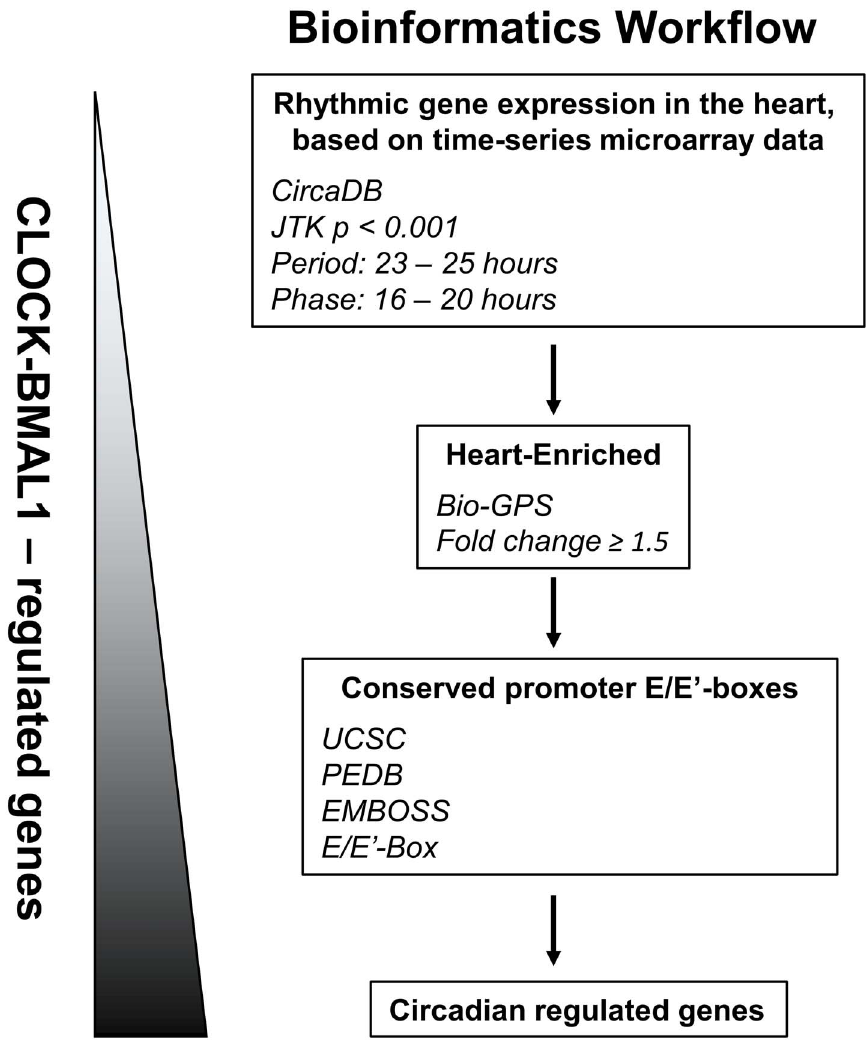
Figure 1. Novel bioinformatics workflow to identify circadian regulated cardiac genes. Distinct patterns of circadian gene expression in the heart were visualized using the Circadian Expression Profiles Data Base (CircaDB) and embedded JTK_Cycle algorithm [19–22] using the JTK_Cycle parameters p , 0.001, period 23 h to 25 h, and phase 16 h to 20 h. The gene list was further enriched for high cardiac mRNA expression levels, using the BioGPS website and GeneAtlas MOE430 gene expression/activity display [28,29]. Genes were selected if they exhibited a $ 1.5 fold increased expression in heart. An in silico circadian motif search was then performed to detect conserved E-box elements in the gene promoter regions that could be used for CLOCK and BMAL1 transcription, using the University of California Santa Cruz (UCSC) table browser tool [30], the circadian mammalian promoter/enhancer database (PEDB) [32], and the European Bioinformatics Institute pairwise nucleotide alignment tool (EMBOSS) [33]. Circadian regulation of candidate gene Tcap was investigated experimentally using in vivo and in vitro approaches. doi:10.1371/journal.pone.0104907.g001 PLOS ONE |